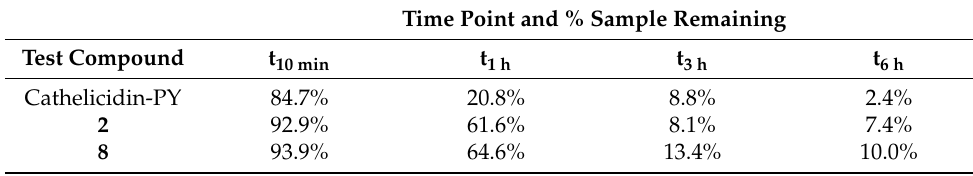
Table 2. Stability assay of cathelicidin-PY, 1 , and analogues 2 and 8 in human serum at various time points as determined by RP-HPLC (214